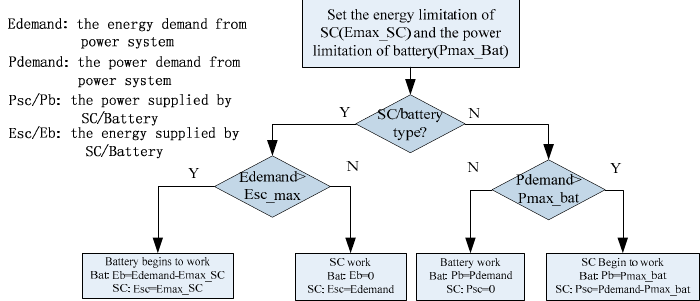
Figure 18. Energy management of